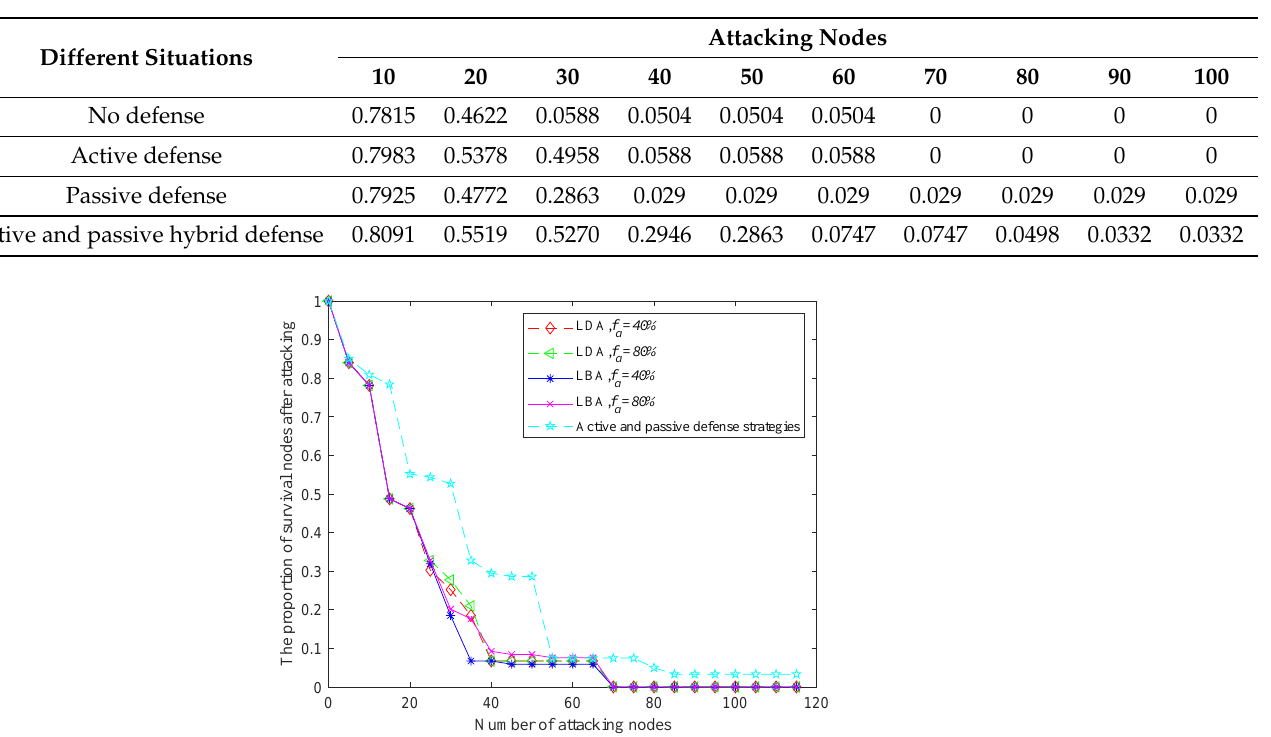
Figure 13. The effect of active and passive defense strategies. Table 7. The propotion of survival nodes.